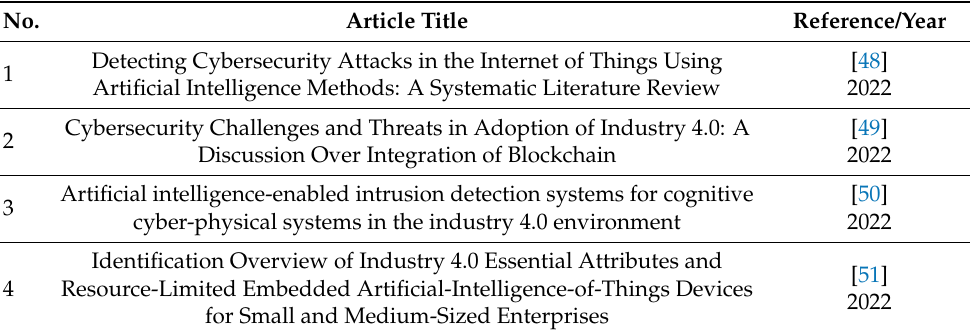
Figure 2. Keywords. Table 2. Search results.